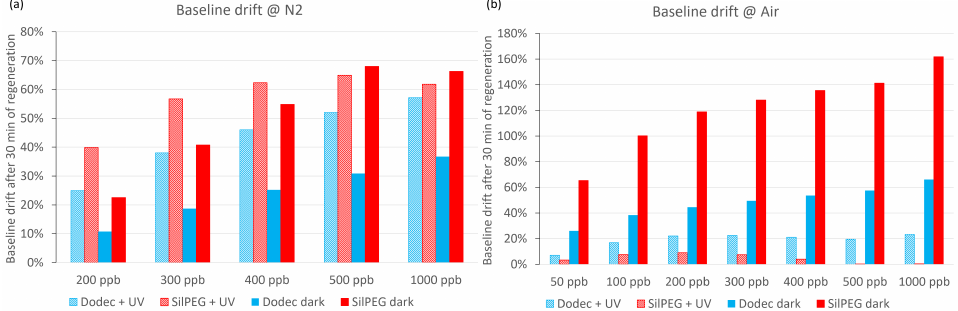
Figure 7. Baseline drifts: ( a ) at nitrogen conditions; ( b ) at air conditions. Selectivity was also determined for the interaction of sensors with other common gas analytes, including reducing (NH 3 ) and neutral (CO 2 ) gases (Figure 8b). The influence of relative humidity (50%) itself on the sensor response was also investigated. The obtained results show a selectivity for NO 2 (over 144% to 1 ppm) relative to that of NH 3 (over 123% to 10 ppm). SilPEG for all tested gases showed a higher sensitivity than DodecSIL.